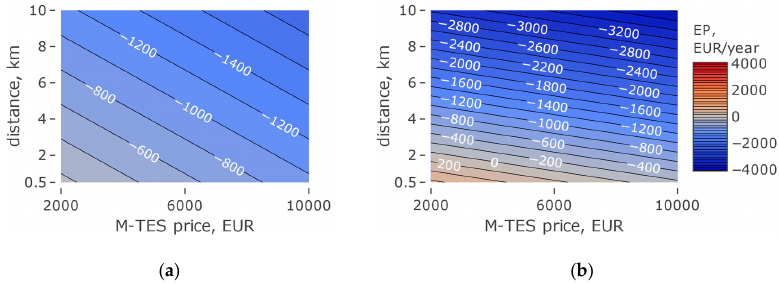
Figure 16. The Yearly Economical Profitable as a function of M-TES price and distance between Geothermal Base Station and Building, for LCOH.OS = 0.1 EUR/kWh and for: ( a ) Total Heat Demand (THD) = 5000 kWh/year; ( b ) THD = 25,000 kWh/year.